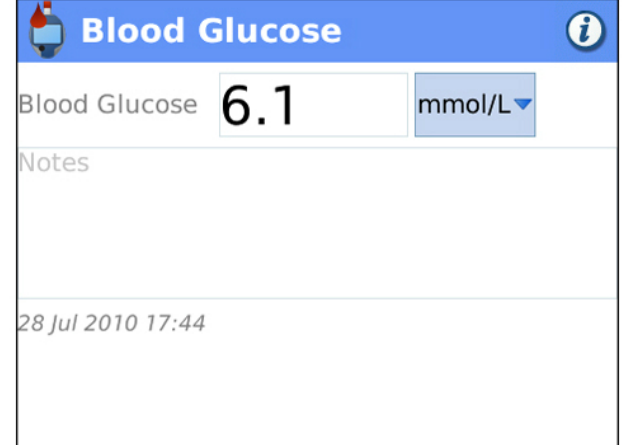
Figure 5. Blood Glucose Tracker: Clients enter blood glucose level and comments on readings.